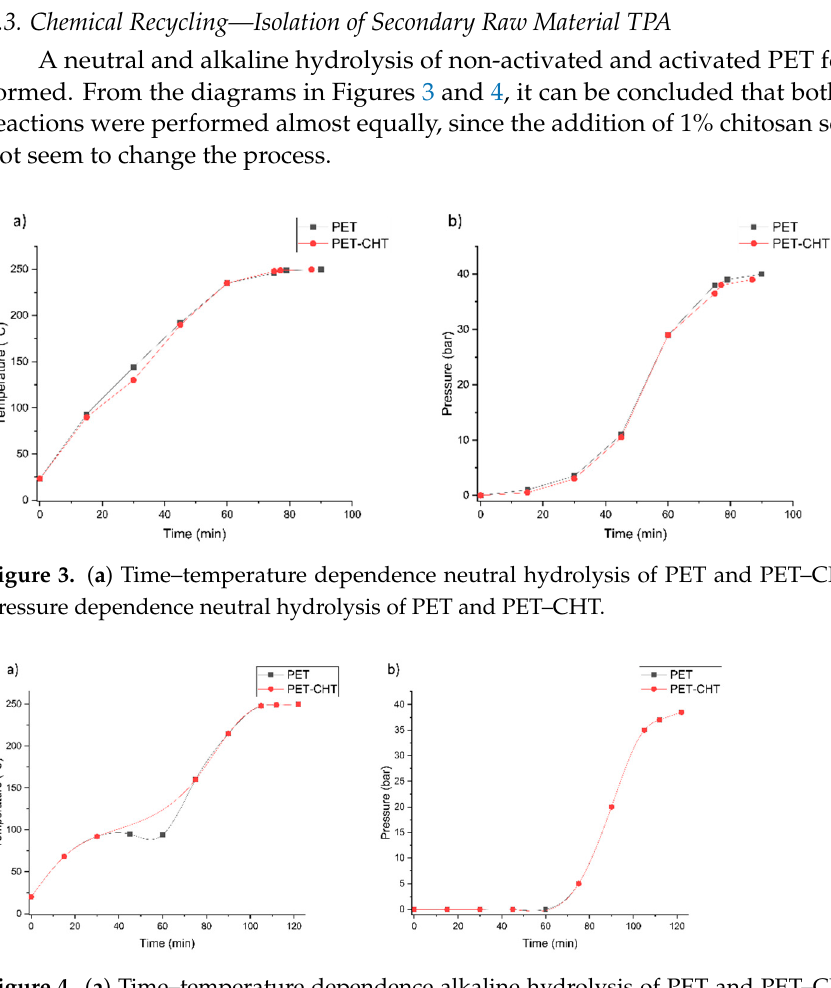
Table 1. Reduction, R (%), of selected microorganisms after exposure to differently treated PET foil, as obtained by ASTM E 2149-01 (2002) standard test.